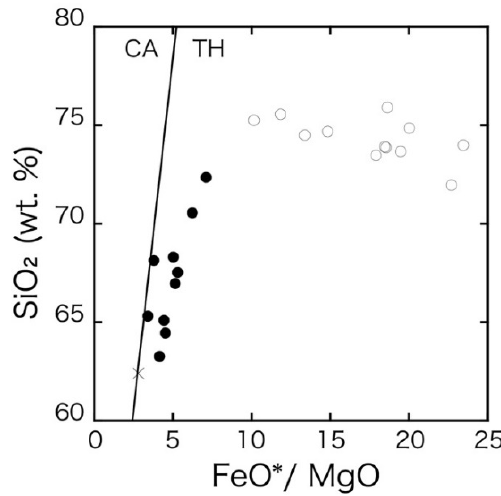
Figure 3. FeO*/MgO-SiO 2 diagram [21] for the rocks in the Hisakajima Island. Solid circles—GD group samples. Open circles—HFG group samples.Cross mark—dike sample. TH—tholeiitic series. CA—calc-alkalic series. Dike samples GTA-2b and GTB-5b fall outside the plotting range. Total Fe as FeO*.